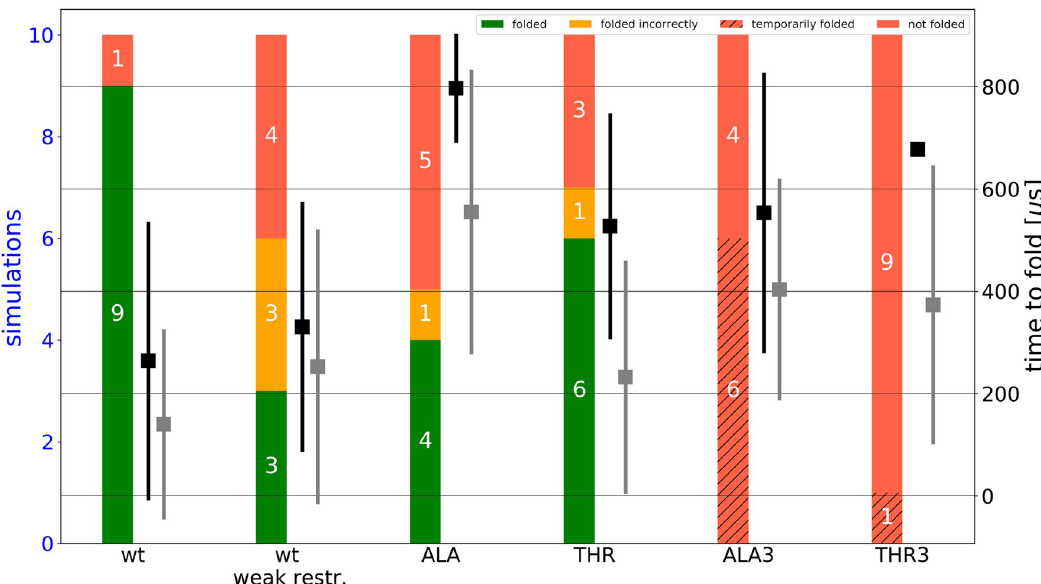
Fig 5. Efficiency and folding times of all simulations. Each column includes 10 simulations. Successful simulations are colored green. Simulations reaching only partly helical and stable folded peptides are colored orange and all simulations which resulted in an unfolded peptide are colored red. Red hatched bars indicate simulations which temporarily folded but subsequent unfolding. Black squares represent the average time to observe a completely folded triple helical structure. Grey squares represent the same time to result in folding up to half of the fully folded structure. Weaker restraints (positional restraints with respect to the native structure on the C α atoms of the last 2 residues of 0.05 kcal � mol -1 � Å -2 vs. 0.5 kcal � mol -1 � Å -2 for the standard set of simulations) do not modulate the folding propagation time but the efficiency and the appearance of misfolded structures. A single point mutation of G ! A/T at the center of one chain already increases the folding time and lowers the efficiency. Three point mutations of G ! A/T (one at the center of each chain) do not result in a single successfully and completely folded triple helix.